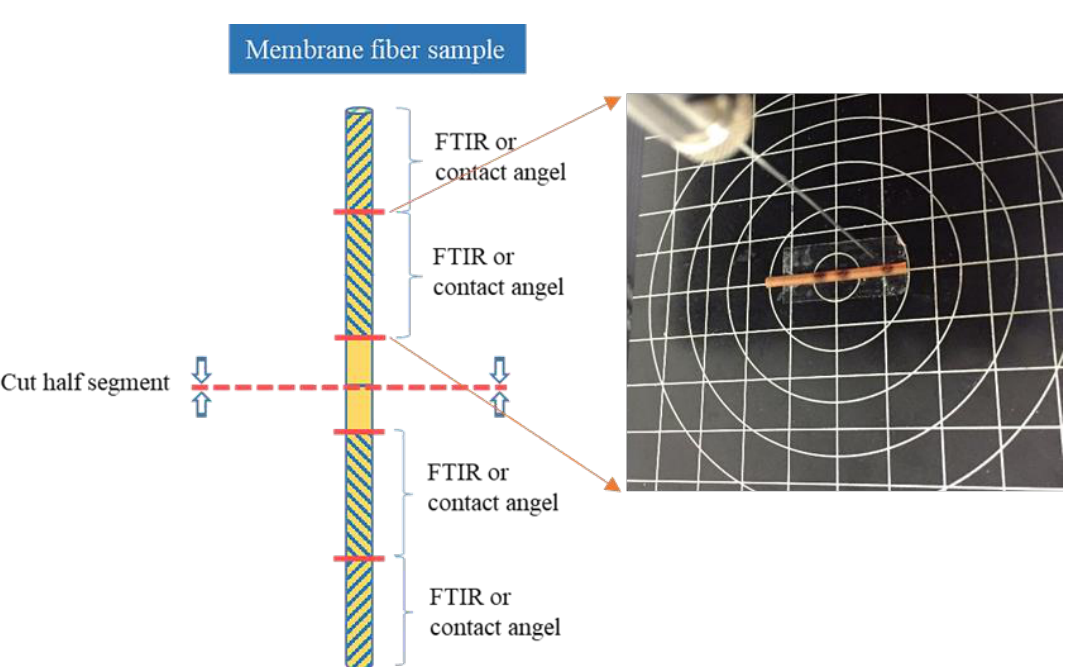
Figure A5. FTIR and contact angle analyses of representative specimens of virgin and fouled MF and UF membranes.